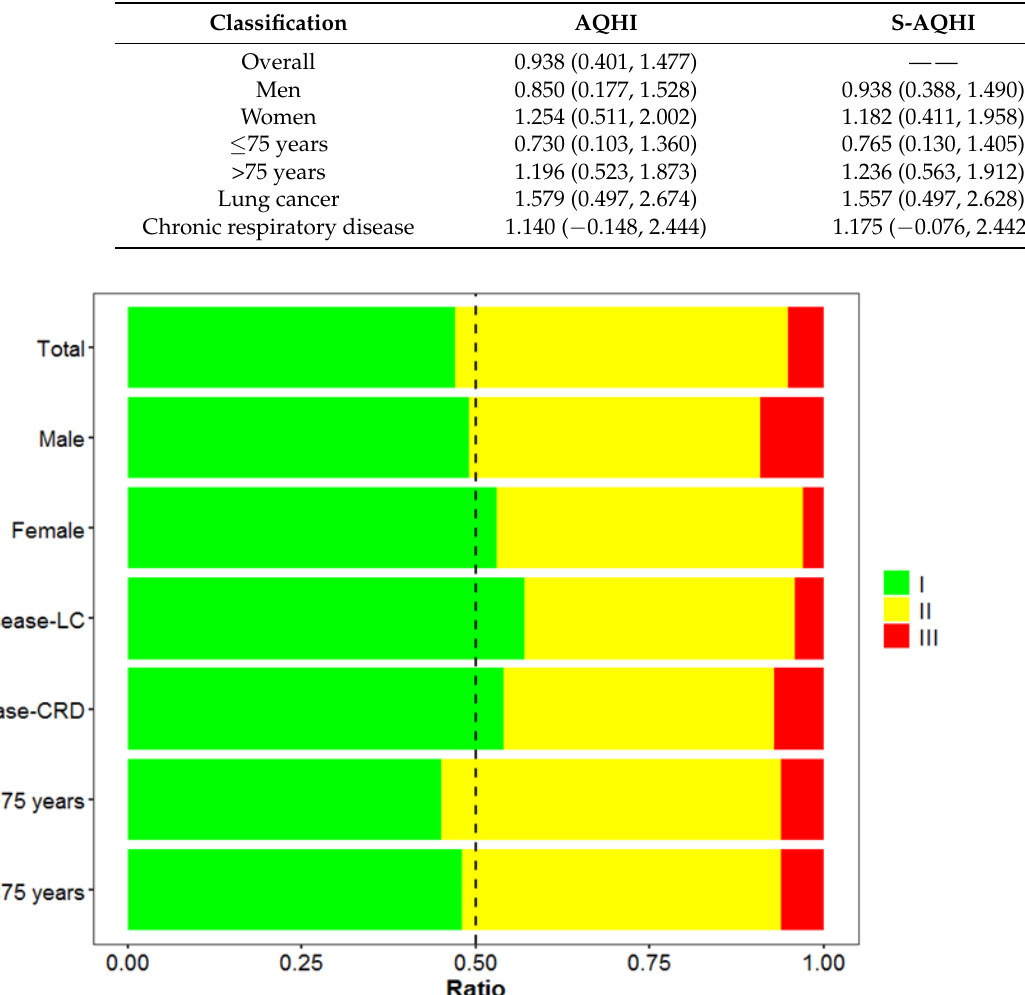
Figure 4. Comparison of the AQHI and S-AQHI classification statistics in Beijing from 2018 to 2020. The relative deviation in the AQHI and S-AQHI for changes in the daily mortality